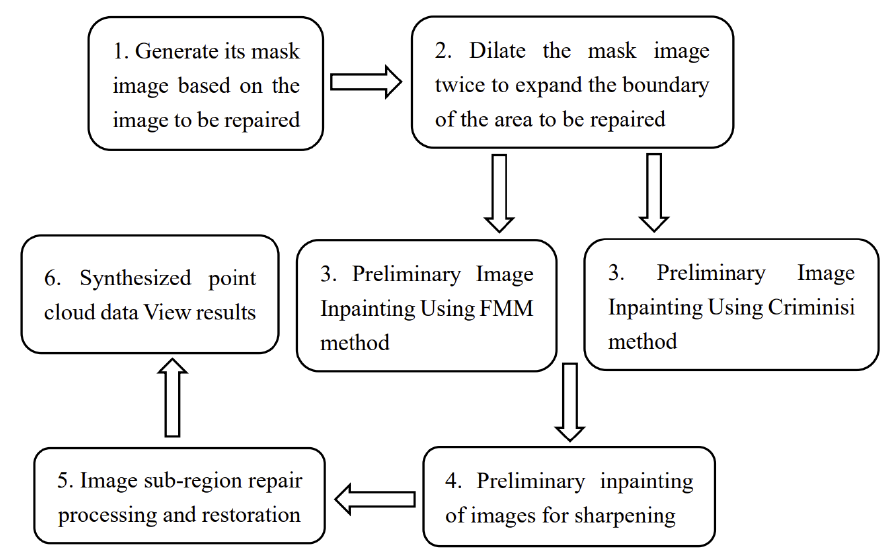
Figure 5. The flow chart of the method proposed in this paper.